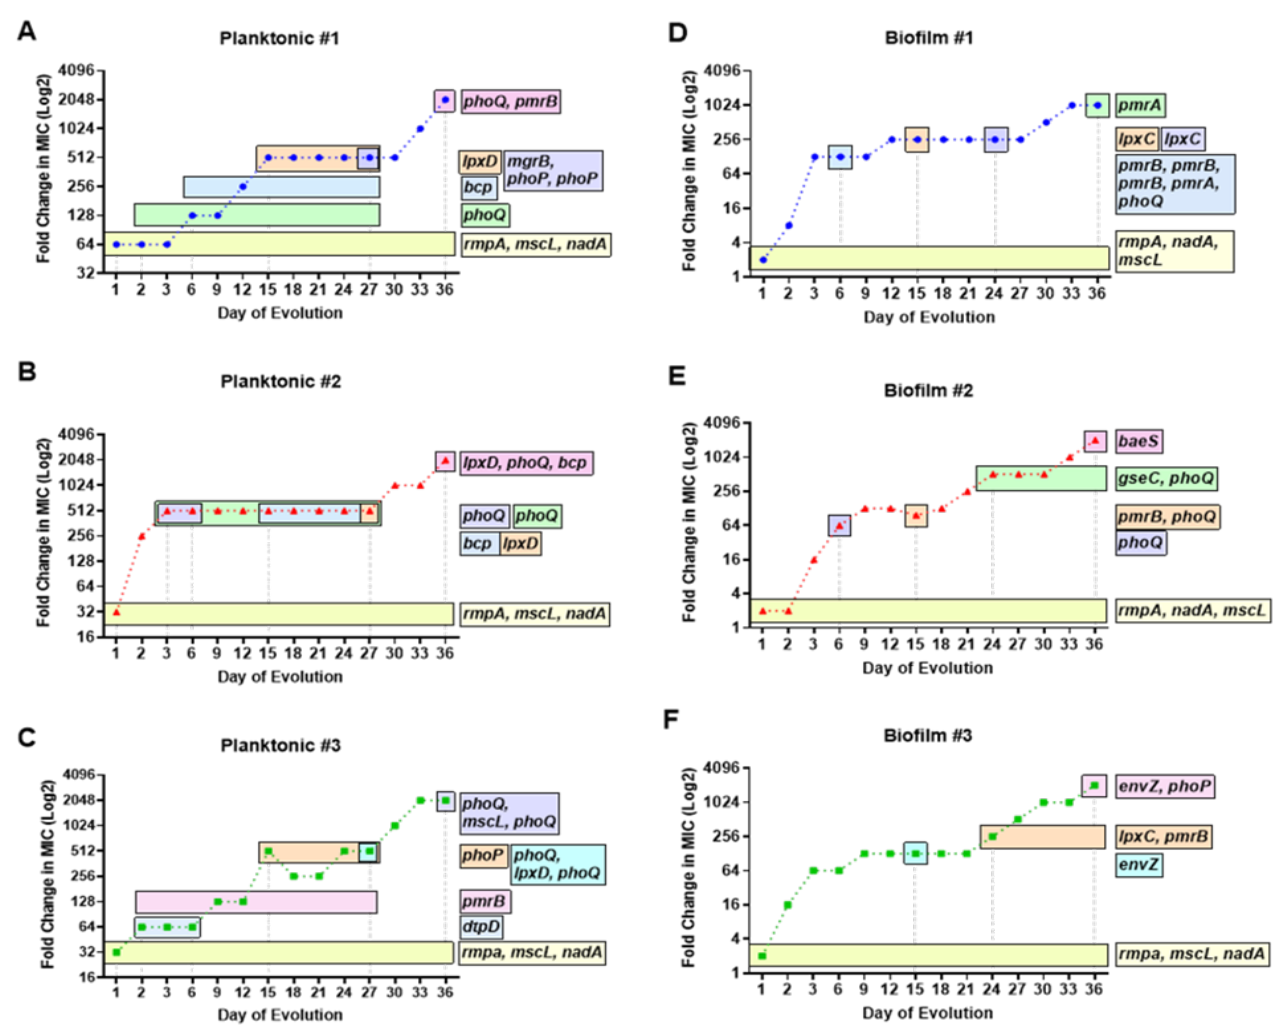
Figure 3. Temporal regulation of colistin-resistant mutations in planktonic and biofilm KP populations. Timelines of acquired mutations having mutation frequencies greater than 10% in known and theorized COL-R genes are represented by horizontal bars throughout a 36 day evolution. The duration of evolution in which the COL-R mutations exist within each planktonic ( A – C ) and biofilm ( D – F ) population is compared against colistin MIC. For both lifestyles, mutations in genes rmpA , nadA , and mscL were generated after 24 h at ½ MIC colistin selection and were subsequently fixed in each population. Planktonic populations 1 ( A ) and 2 ( B ) acquired a mutation in bcp around midpoint of evolution followed by mutations in lpxD . Biofilm populations 1 ( D ) and 3 ( F ) acquired mutations in lpxC around midpoint of evolution. Mutations in two component system sensor regulator genes phoQ / phoP and histidine kinase genes pmrB / pmrA appeared sporadically, in relation to notable (at least twofold) increases in colistin MIC. Table 1. Timepoint and MIC of acquired COL-R mutations in planktonic evolved KP populations. COL-R mutations are represented for each individually evolved KP population with colistin MIC (µg/mL) and population frequency. Mutations with shared gene positions between populations are shaded gray. Shared mutations in genes that are acquired in independently evolved populations are color-coded for comparison. Mutations unique to individual populations are in white back- ground. The shading is darker for mutations with higher population frequency.